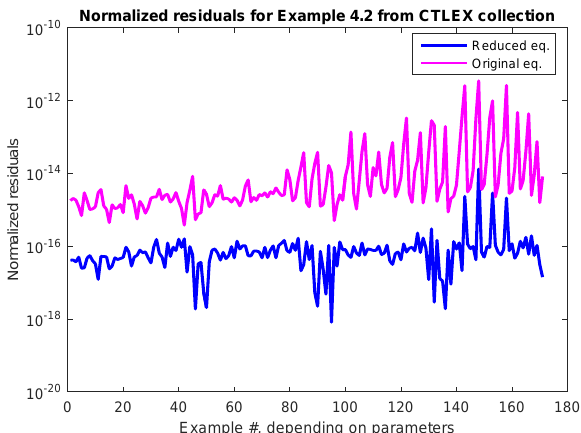
Figure 17. Normalized residuals for reduced and original Lyapunov equations for CTLEX 4.1 series of examples, using the ArLyap solver.